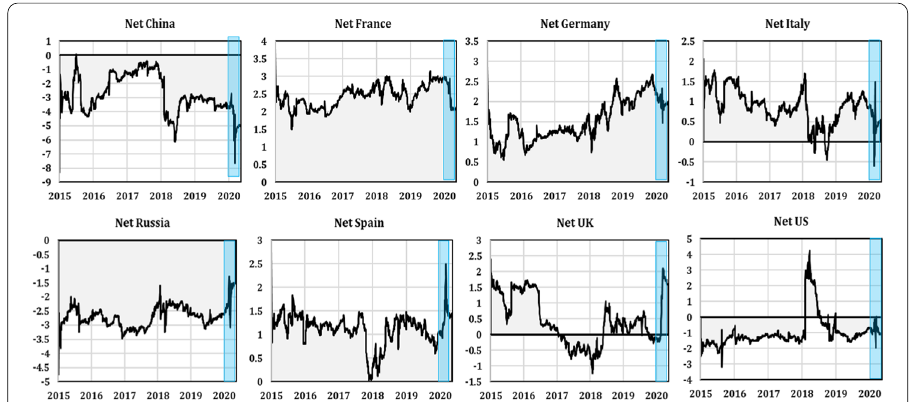
Fig. 5 Net dynamic spillover of the stock market in each country (the shaded blue area indicates the period of the COVID-19